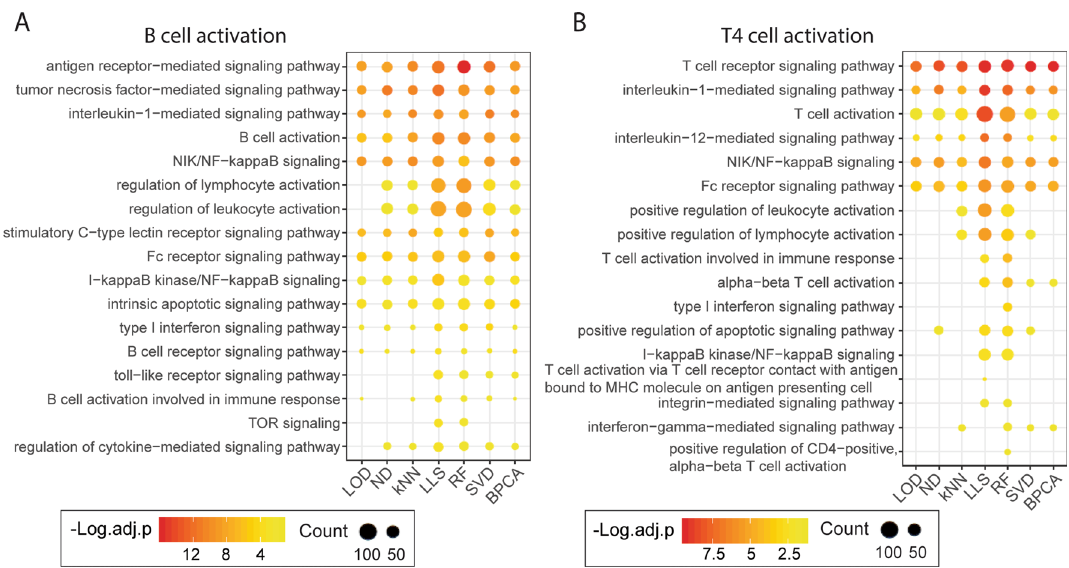
Figure 6. Enriched pathways of B cell and T4 cell activation with the immune cell dataset. Selected activation processes and signaling pathways that are significantly enriched (adjusted p-value < 0.05) in DE proteins of ( A ) B cell activation and ( B ) T4 cell activation. This figure was generated with R 3.6.1 (https ://www.r-proje ct.org) package ggplot2 v 3.2.1 (https ://ggplo t2.tidyv